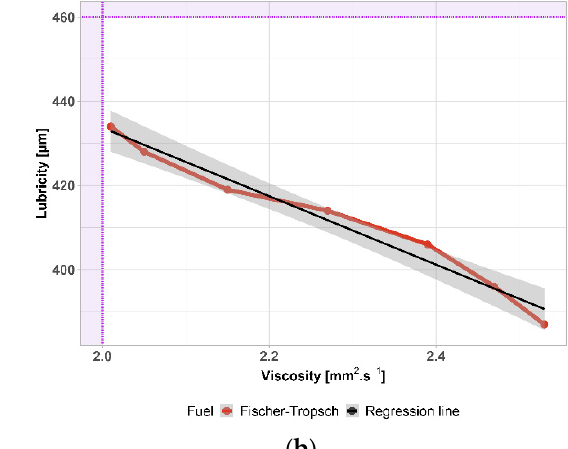
Figure 8. Lubricity of FT − diesel mixtures.